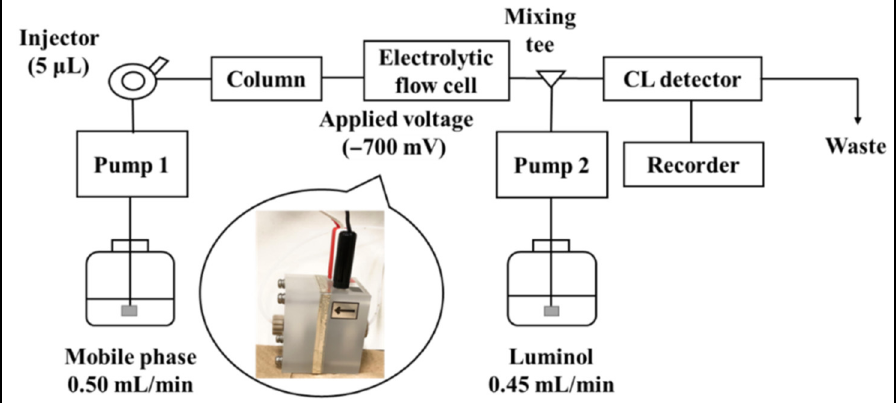
Figure 2. HPLC−CL system employing the electrolytic reduction. Figure 2. HPLC − CL system employing the electrolytic reduction.